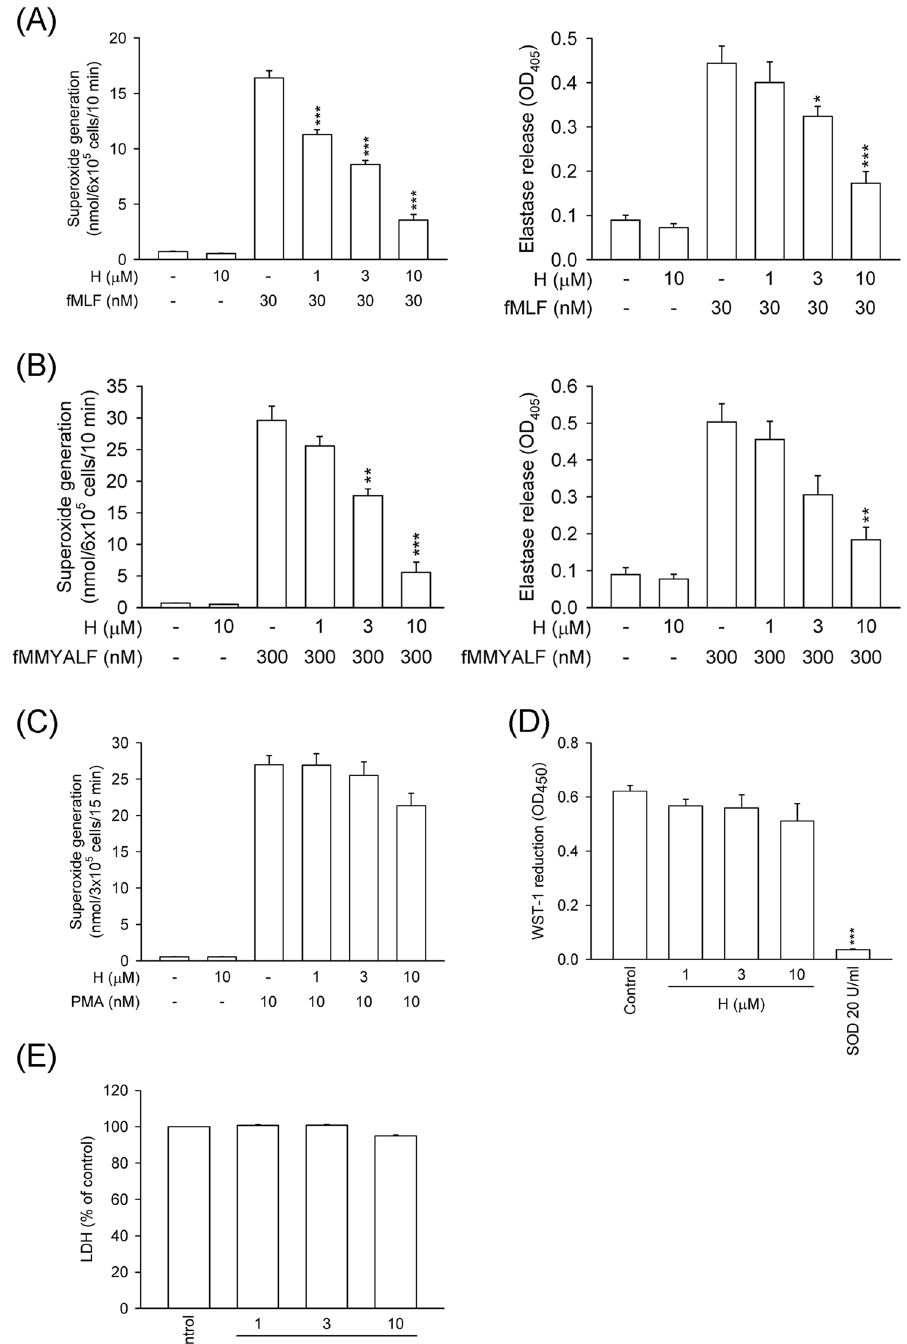
Figure 1. Honokiol inhibits superoxide anion generation and elastase release in FPR1-activated human neutrophils. Human neutrophils were incubated with 0.1% DMSO (as control) or honokiol (H; 1, 3, and 10 μ M) for 5 min, and then activated by ( A ) fMLF (30 nM), ( B ) fMMYALF (300 nM), or ( C ) PMA (10 nM) for another 10 min. When fMLF and fMMYALF were used as activators, cells were primed by pre-incubation for 3 min with cytochalasin B (CB). Superoxide anion production was measured by ferricytochrome c reduction and elastase release was measured spectrophotometrically at 405 nm. ( D ) Xanthine oxidase was incubated with 0.1% DMSO (as control) or honokiol for 3 min, and then xanthine (0.1 mM) was added for 10 min. Reduction of WST-1 by cell-free xanthine/xanthine oxidase was measured spectrophotometrically at 450 nm. Superoxide dismutase (SOD; 20 U/ml) was used as a positive control. ( E ) Human neutrophils were incubated with 0.1% DMSO (as control) or honokiol for 15 min. Cytotoxicity was measured by assessing LDH release in cell-free medium. Total LDH release was determined by lysing cells with 0.1% Triton X-100 for 30 min at 37 °C. All data are expressed as the mean ± S.E.M. ( n = 3–5). * P < 0.05, ** P < 0.01, *** P < 0.001 compared with ( A ) fMLF, ( B ) fMMYALF, or ( D ) control (0.1%